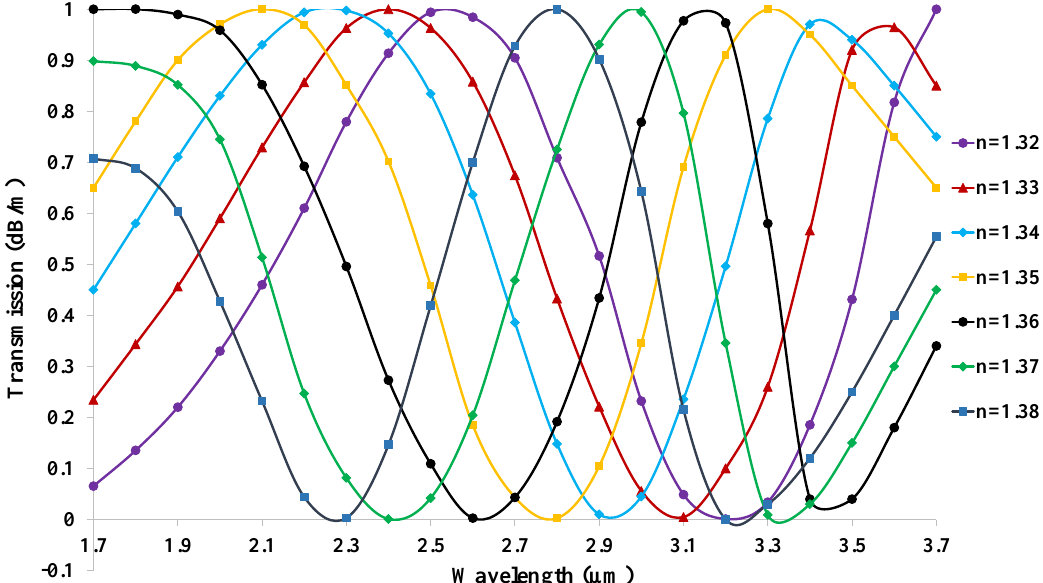
Figure 5. The transmission spectrum variations in dB/m scale of the proposed C − PCF versus